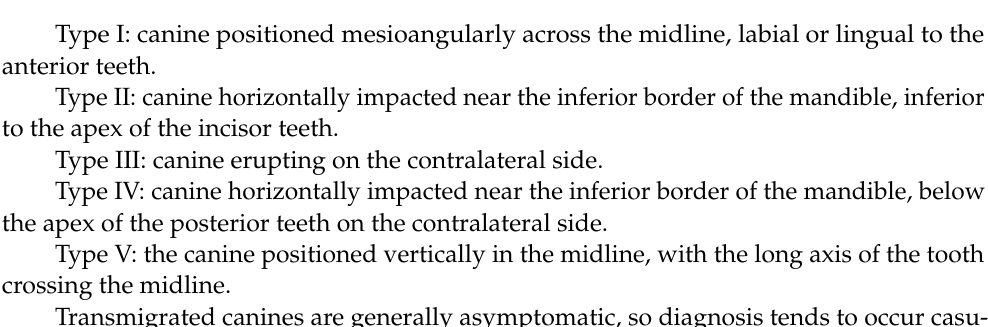
Figure 1. Mupparapu’s